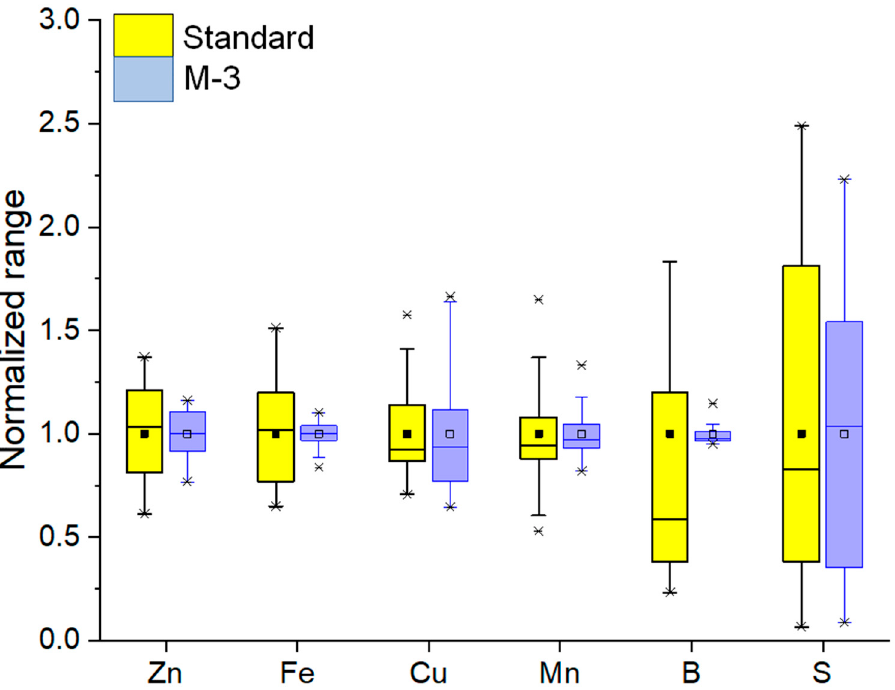
Figure 1. Boxplots of traditional and Mehlich-3 (M-3) soil-extractable nutrients. Single results were divided by the average to normalize data and plot variables in the same range. Boxes span the 25th to 75th data percentile, whiskers represent 1.5 × the interquartile range, horizontal lines denote the median, boxes denote the mean, and × denotes the extreme value.